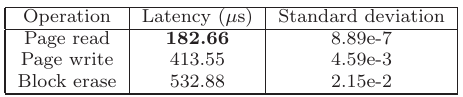
Figure 3: jffs2 readpage() latencies for sequentially reading a fragmented / non fragmented file.